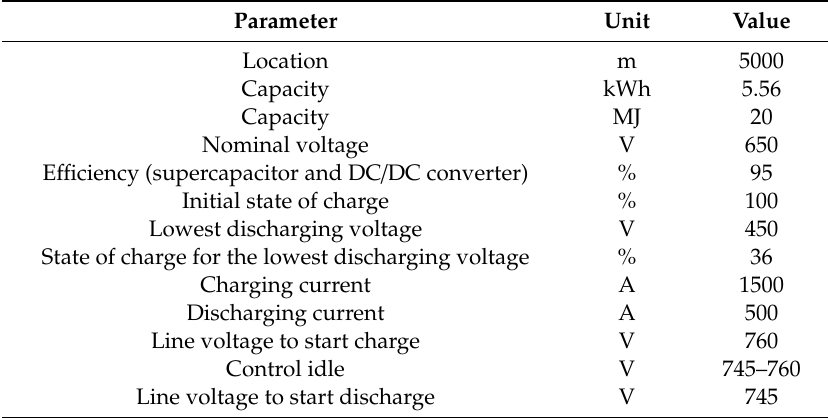
Table 2. WESD input